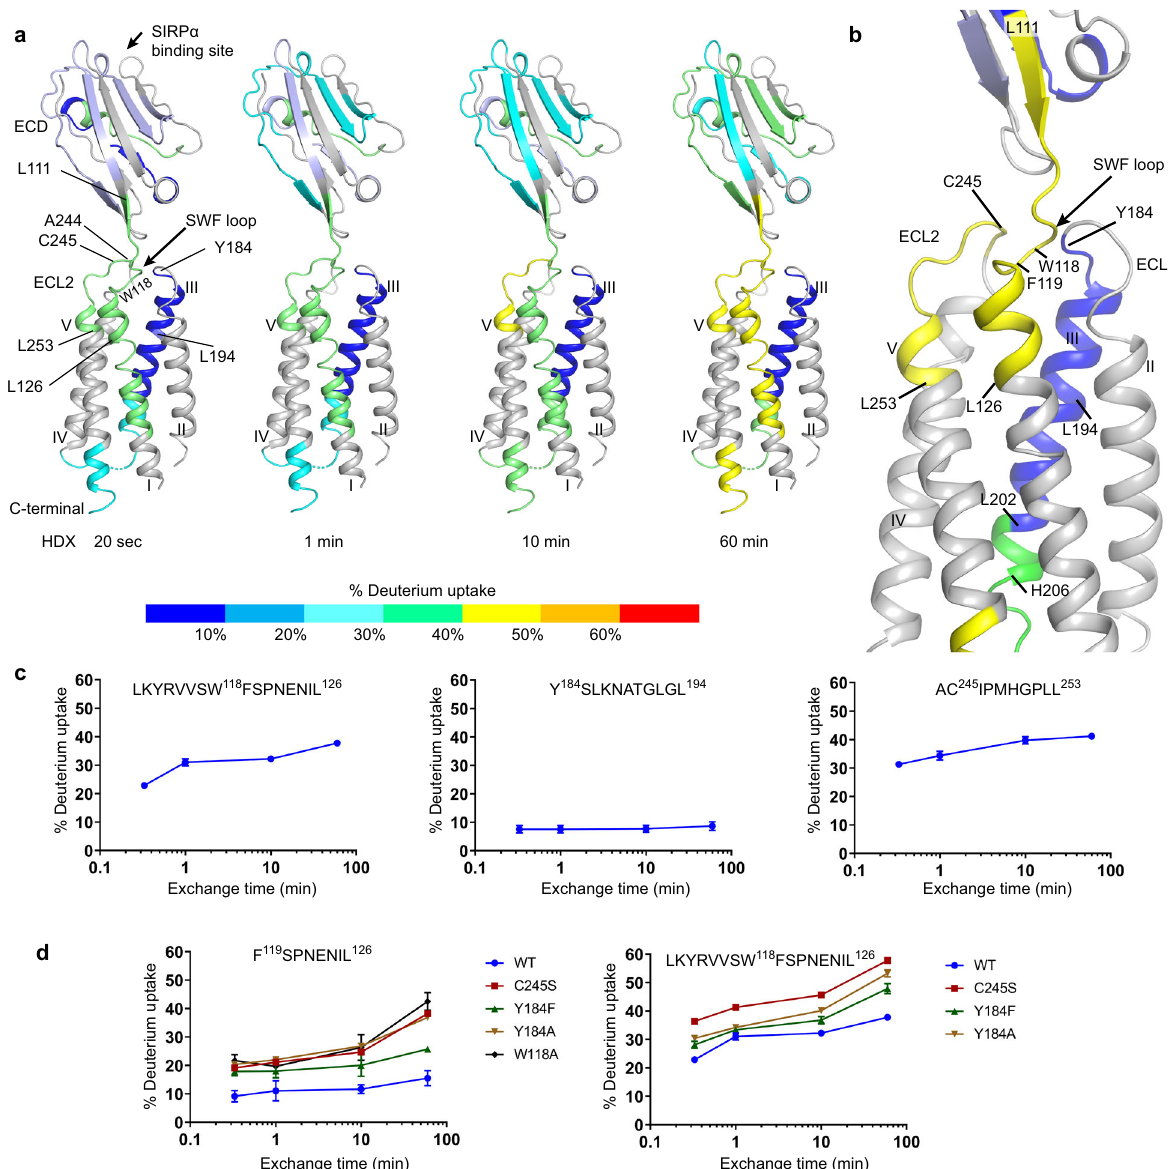
Fig. 5 Kinetic HDX-MS data of WT CD47 BRIL and mutants. a The HDX levels of WT CD47 BRIL and mutants are color coded and mapped onto the crystal structure of full-length CD47 BRIL -B6H12 complex (Fab B6H12 atoms omitted). Regions that were not identi fi ed in the HDX-MS experiments are colored gray. b Close view of the ECLR showing deuterium uptake at 60 min. c Deuterium uptake plots of peptides corresponding to the inter-domain 114 RVSSWF 119 linker region, ECL1 and helix III, ECL2 and the EC portion of helix V. d Deuterium uptake plots of WT CD47 BRIL and mutants for peptides covering the 114 RVSSWF 119 linker region. Each data-point is presented as mean values across two replicates. Error bars represent mean values ± SD of duplicate measurements. At least two independent experiments were performed with a panel a receptor constructs. The kinetic differential HDX data are provided in Supplementary Data